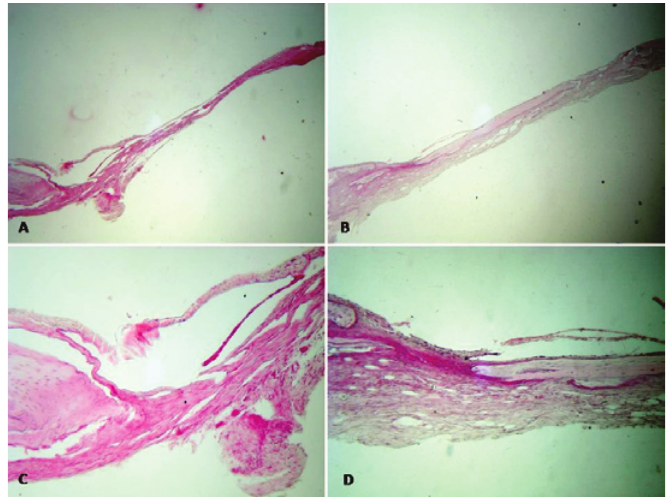
FIGURE 1 – A. Presence of fibrosis (HE 40x); B. Close up of the bone defect margin and the fibrous tissue (HE 100x); C. Partial bone filling with fibrosis (HE 40x); D. Close up of the partial bone filling with fibrosis (HE 100x).